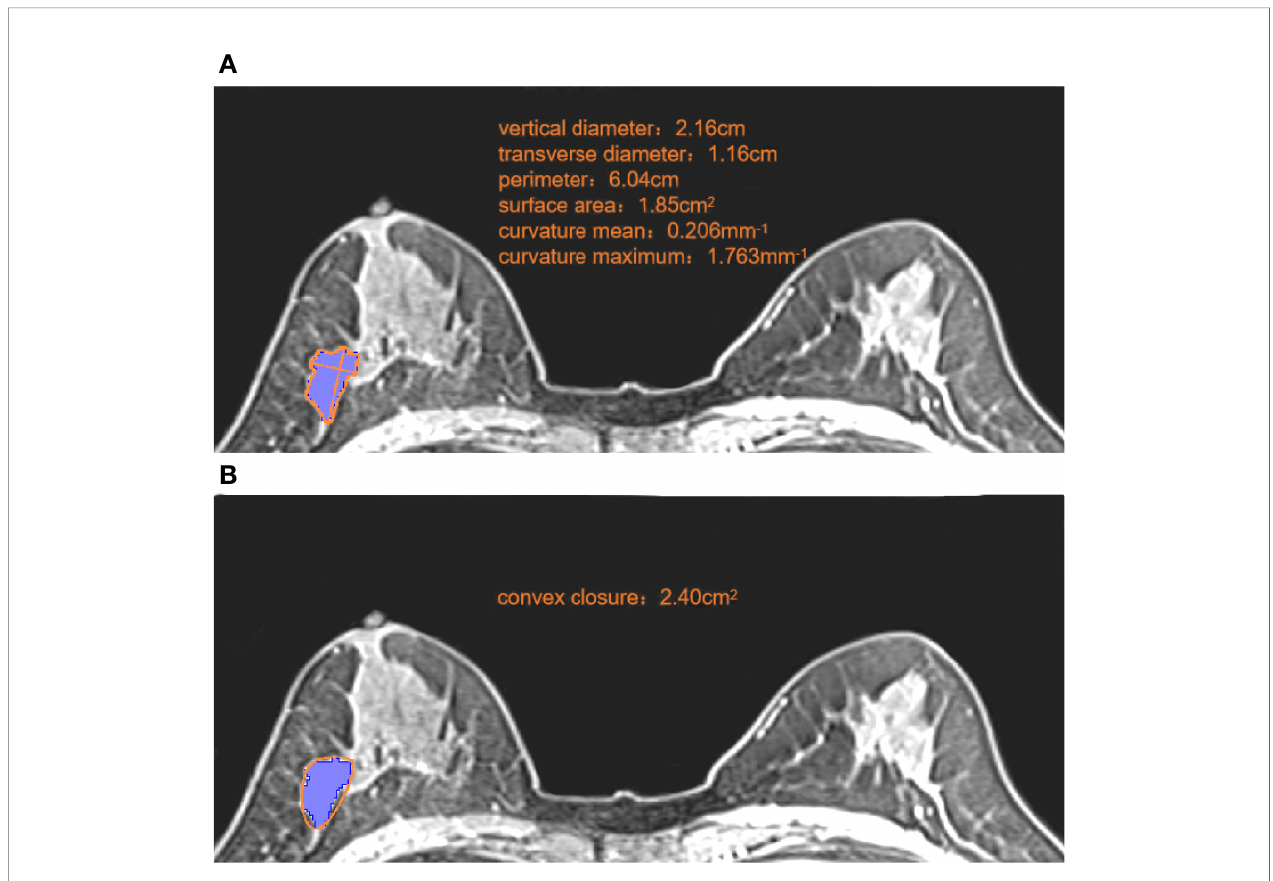
FIGURE 2 | Measurement of morphologic parameters. (A) We measured the vertical diameter and transverse diameter at the largest cross-section. We drew along the edge of the lesion, and obtained the perimeter, surface area, curvature mean, and curvature maximum. Roundness = 4 p ×1.85/6.04 2 = 0.64 (B) We made a small convex polygon along the line connecting the edge of the lesion to obtain the convex closure area. Concavity= (2.40-1.85)/2.40 =